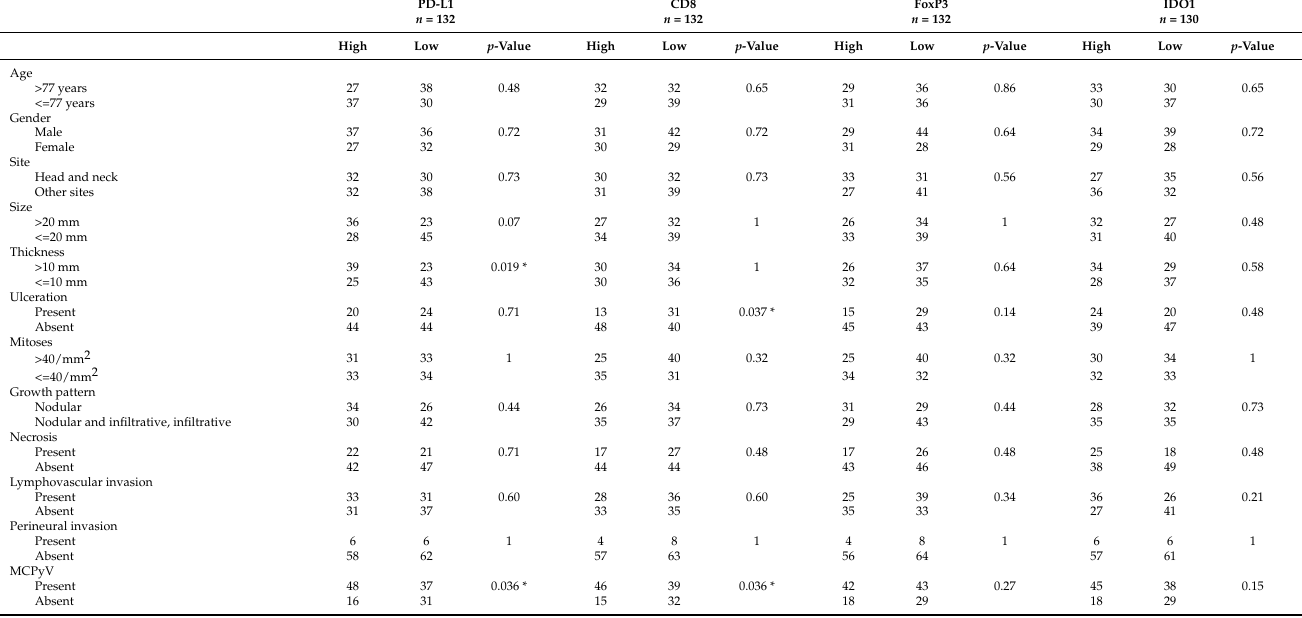
CD8+ Cell Count The clinicopathologic characteristics associated with tumoral PD-L1 expression, tu- moral IDO1 expression, intratumoral CD8+ cell count, and intratumoral FoxP3+ cell count evaluated with Fisher’s exact tests are summarized in Table 1. Tumoral PD-L1 expression >1% significantly correlated with tumor thickness >10 mm ( p = 0.0048) and positive MCPyV status ( p = 0.018). High intratumoral CD8+ cell count significantly correlated with absence of ulceration ( p = 0.0092) and positive MCPyV status ( p = 0.018). Table 1. Summary of clinical, histologic, and immunohistochemical